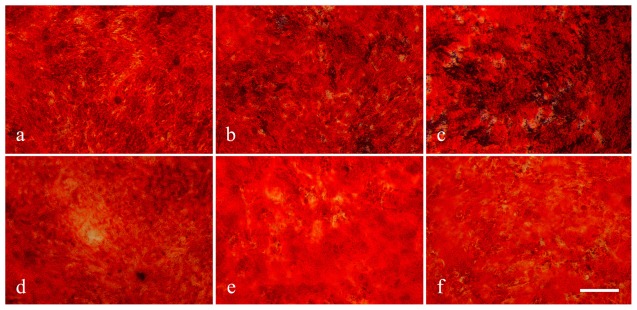
The effect of leptin on osteogenesis of MSCs from a normal control (22y, male) and an AIS patient (18y, male, Cobb angle = 88°).Cells from the normal control were induced along the osteogenic differentiation with human recombine leptin protein at concentration of 0 µg/mL (a), 0.015 µg/mL (b) and 0.6 µg/mL (c). MSCs from the AIS patient were also treated under the same condition that contained leptin of 0 µg/mL (d), 0.015 µg/mL (e) and 0.6 µg/mL (f). At day 21, the cells were subjected to Alizarin Red S staining. Scale bar = 500 µm.